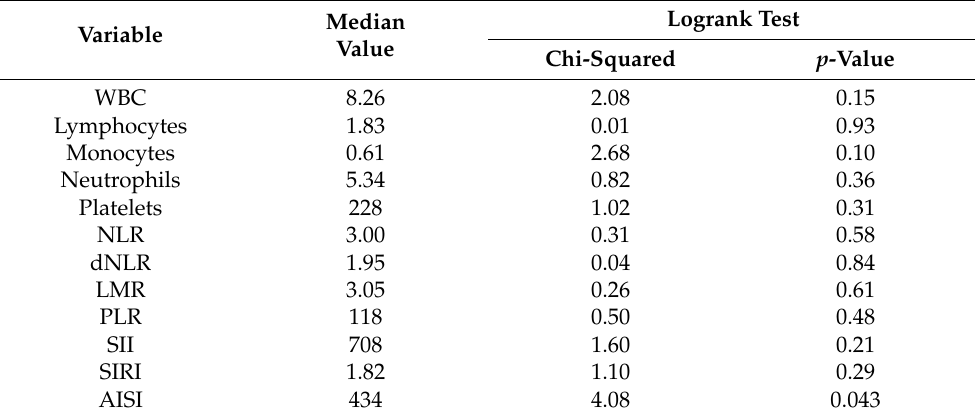
Table 4. Kaplan–Meier survival analysis of simple and combined blood cell count indexes in patients with IPF.